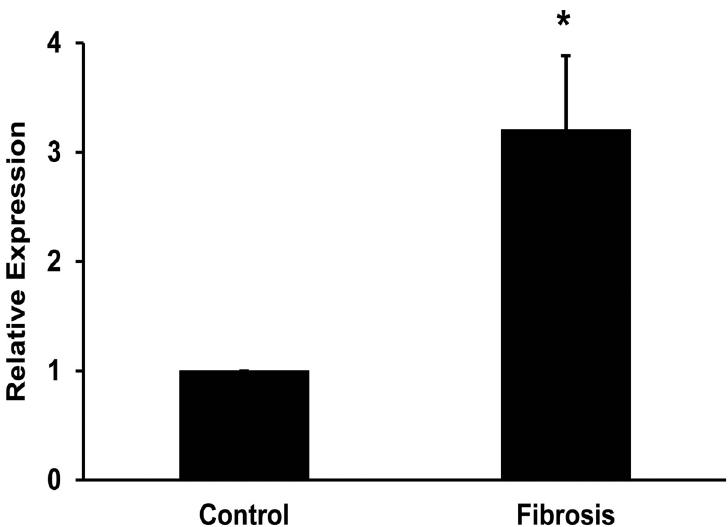
Fig 1. Expression of miRNA-181a in liver tissues. The liver tissues were obtained from the liver transplant participants. Total RNA was purified from the liver tissues of the donors (healthy liver samples) and recipients (cirrhotic patients). cDNA was synthesized and real-time RTPCR was performed to determine the expression of miRNA-181a (n = 5; � p < 0.05, compared to healthy controls).